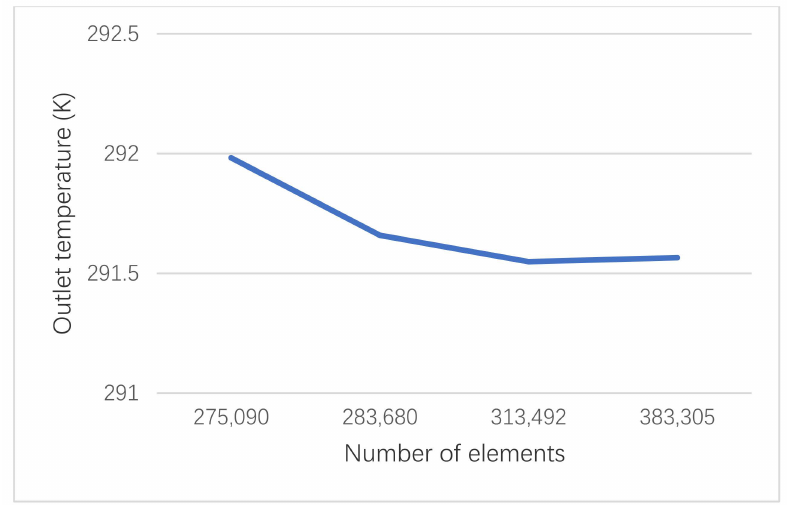
Figure 4. Grid independence test on the outlet temperature.